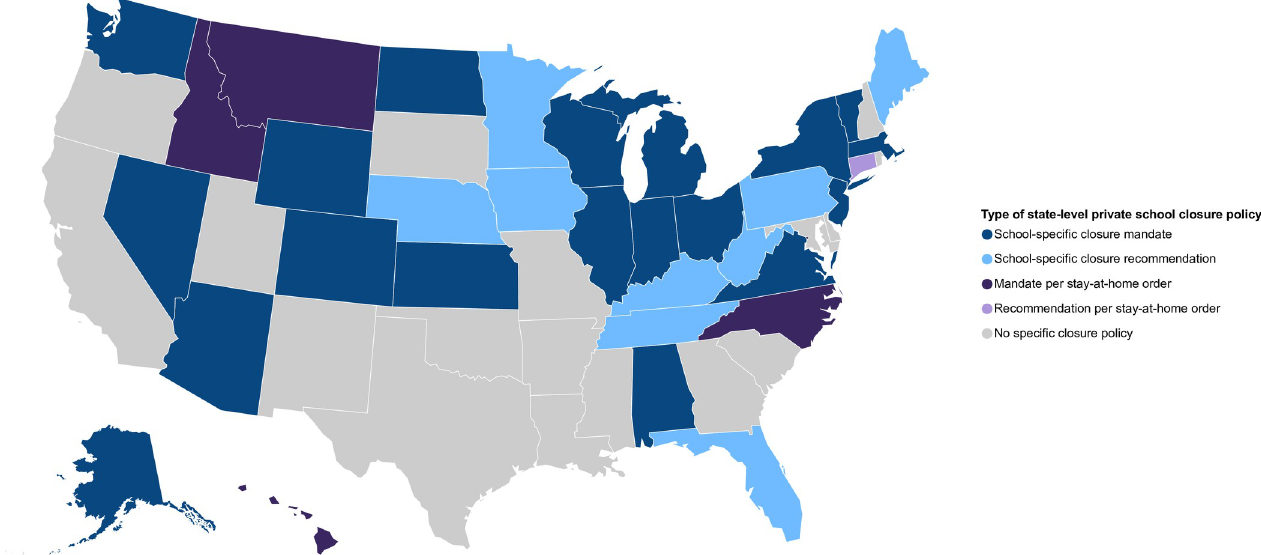
Fig 3. Type of statewide coronavirus disease 2019 private K-12 school closure policies–United States, March–June 2020. Data Sources, Reference, & Notes: Data were collected via daily searches of publicly available online content. A standard set of search terms were used to identify COVID-19-related school closures lasting � 1 day. Official state-level health and education department websites were also searched. The map shows the type of state-level closure policies for the academic year 2019–2020 for private K-12 schools in which schools are physically closed for students. Schools may have used distance learning to continue education from home. Orders and recommendations for statewide closure originated from state governors and/or state education departments.